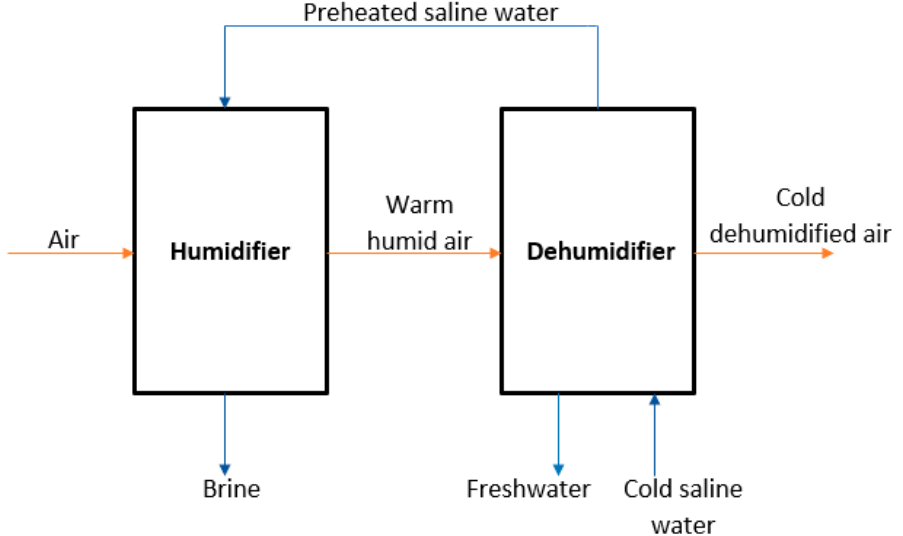
Figure 4. Schematic of a simple HDH desalination system.